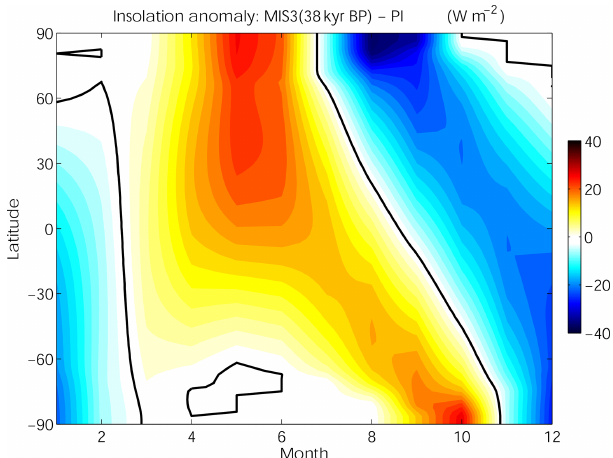
Figure 1. The insolation anomalies of MIS3 at 38kyrBP relative to present day (Wm − 2 ). The thick contour is the zero